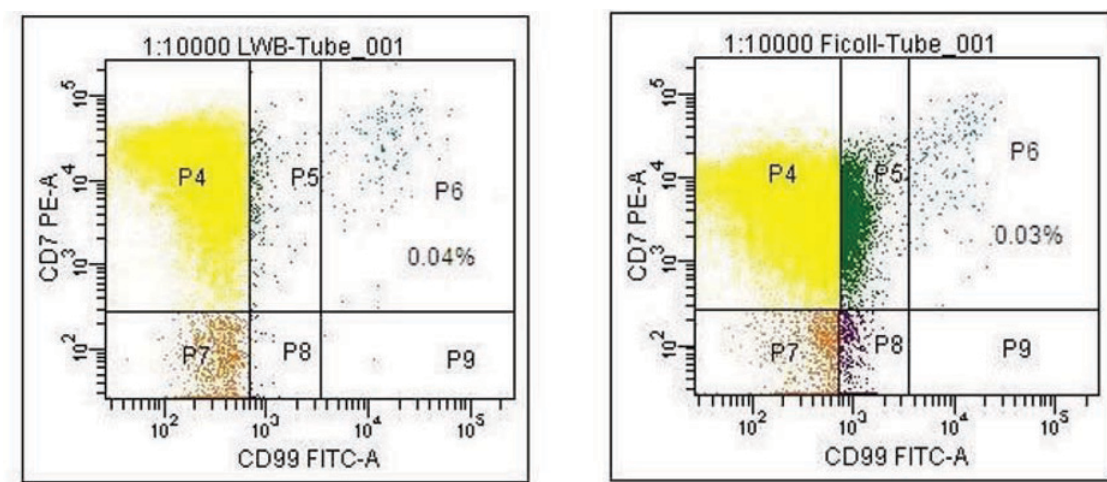
Figure 5b. T-ALL dilution 1:10 000, mononuclear density gradient separation. “2x3 empty block” analysis strategy: population of leukemic T-lymphoblasts located in an empty block P6 makes 0.03% of acquired mononuclear cells.